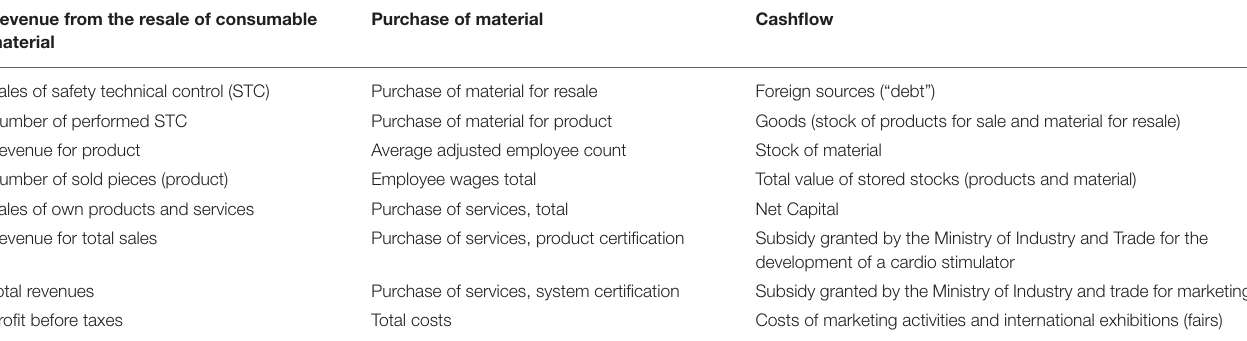
TABLE 2 | Monitored variables.